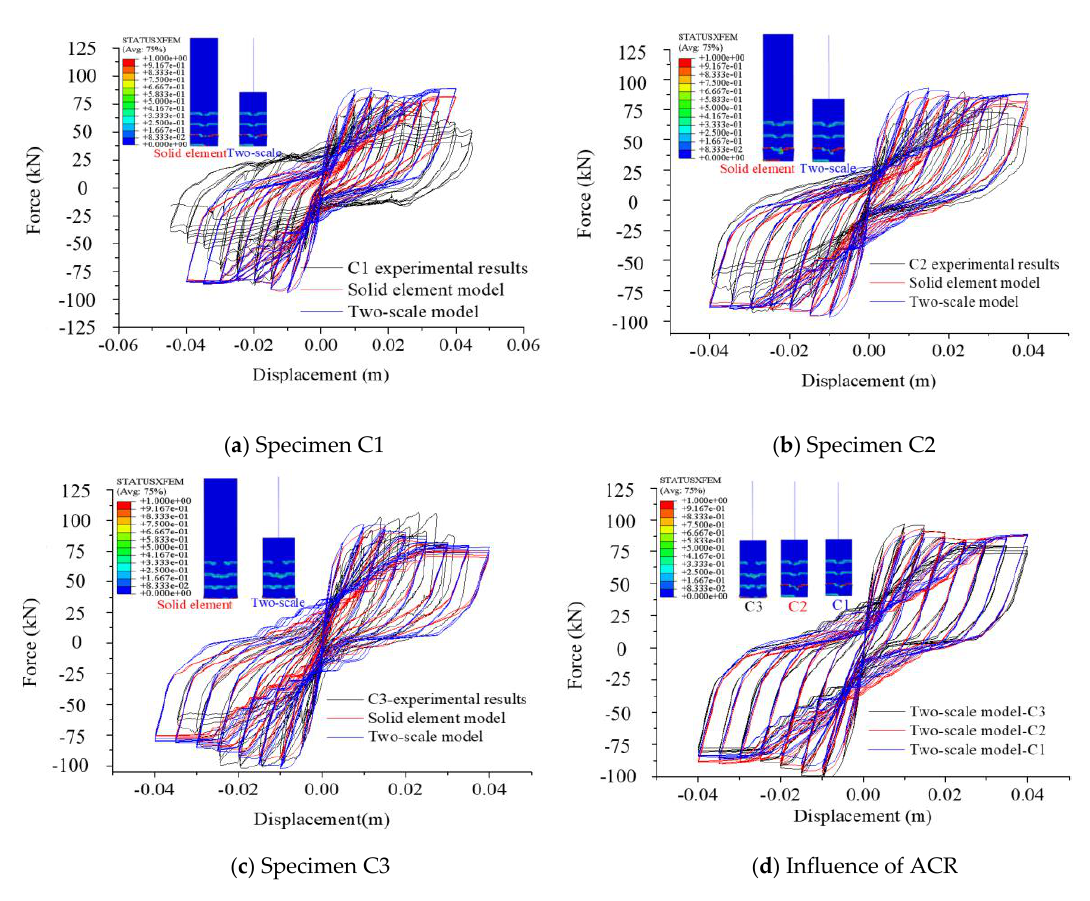
Figure 13. Comparison of load–displacement curves of different specimens. Table 3. Comparison of peak load